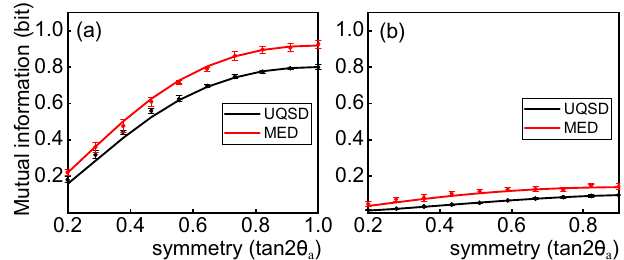
Fig. 6 Mutual information gained via MED and UQSD strategies. The nonorthogonality is ( a ) sin2 θ n ¼ 0 : 2 and ( b ) sin2 θ n ¼ 0 : 9 . The dots are experimental values, while the solid lines are theoretical values. The error bars indicate one standard